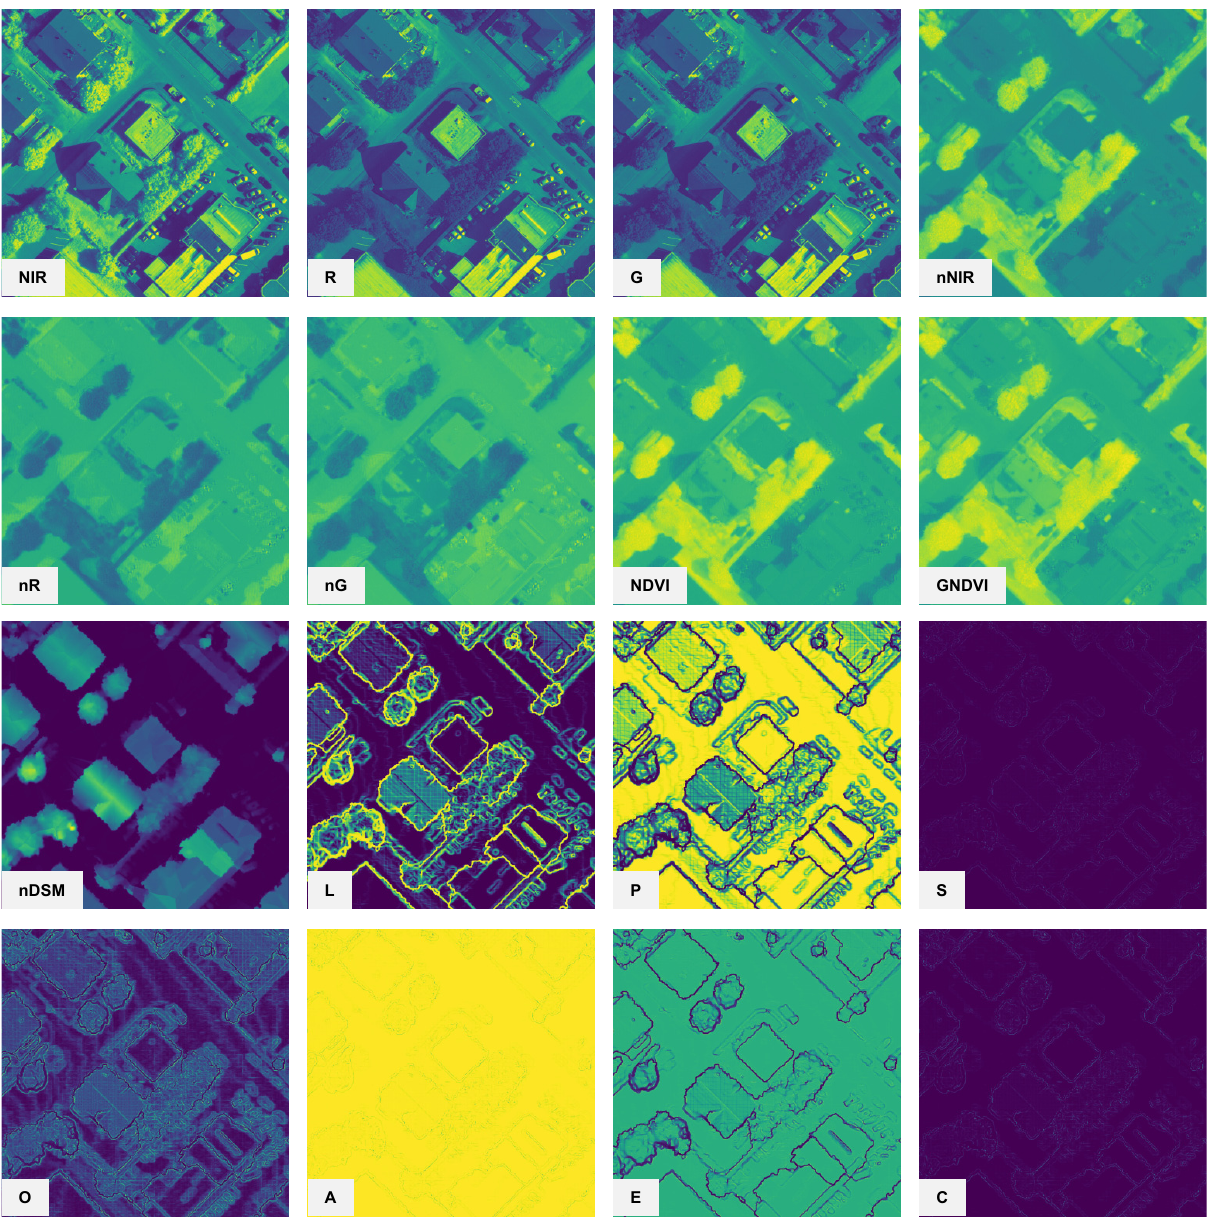
Figure 5. Visualization of the used radiometric information (first and second row) and the used geometric information (third and fourth row) for a part of Patch 30: the color encoding reaches from blue (low values) via green (medium values) to yellow (high